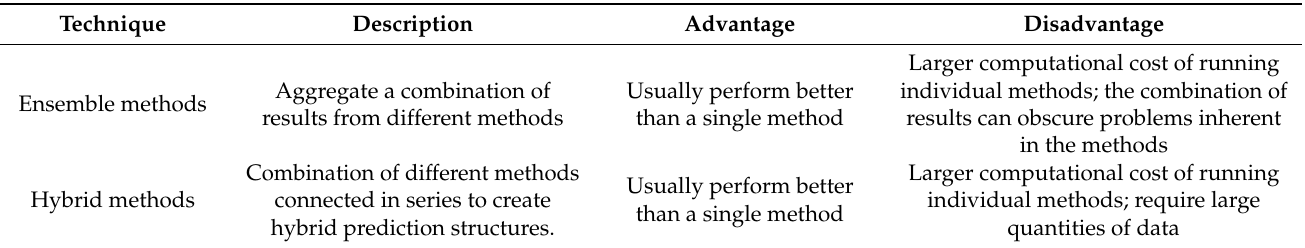
Table 4. Classification of complex forecasting